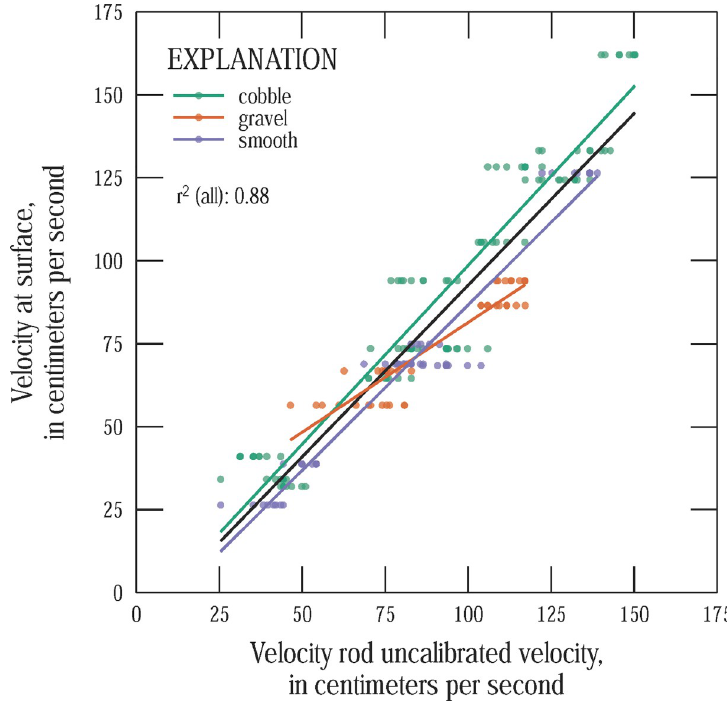
Fig 5. Surface velocity versus (uncalibrated) velocity measured with the velocity head rod method. The colored lines are best fit lines for each substrate type and the black line is the best-fit line for all measurements.